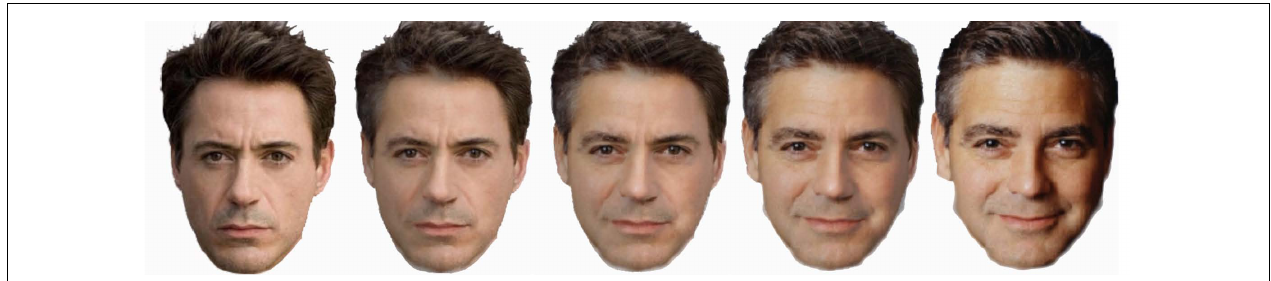
FIGURE 1 | Images of movie actors Robert Downey Jr. (far left photo) and George Clooney (far right photo) and their 75%/25% (left middle), 50% /50% (middle) and 25%/75% (right middle) morph